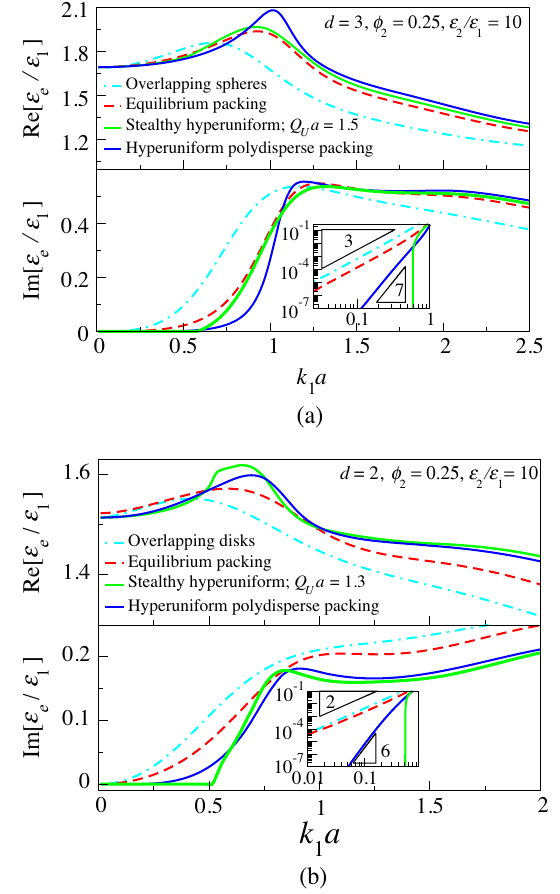
FIG. 10. Predictions of the scaled strong-contrast approxima- tion (73) for the effective dynamic dielectric constant ε function of the dimensionless wave number k 1 a of the four models of disordered media at volume fraction ϕ 2 ¼ 0 . 25 and contrast ratio ε 2 = ε 1 ¼ 10 : (a) three dimensions and (b) two dimensions. The inset in the lower panel is the log-log plot of the larger